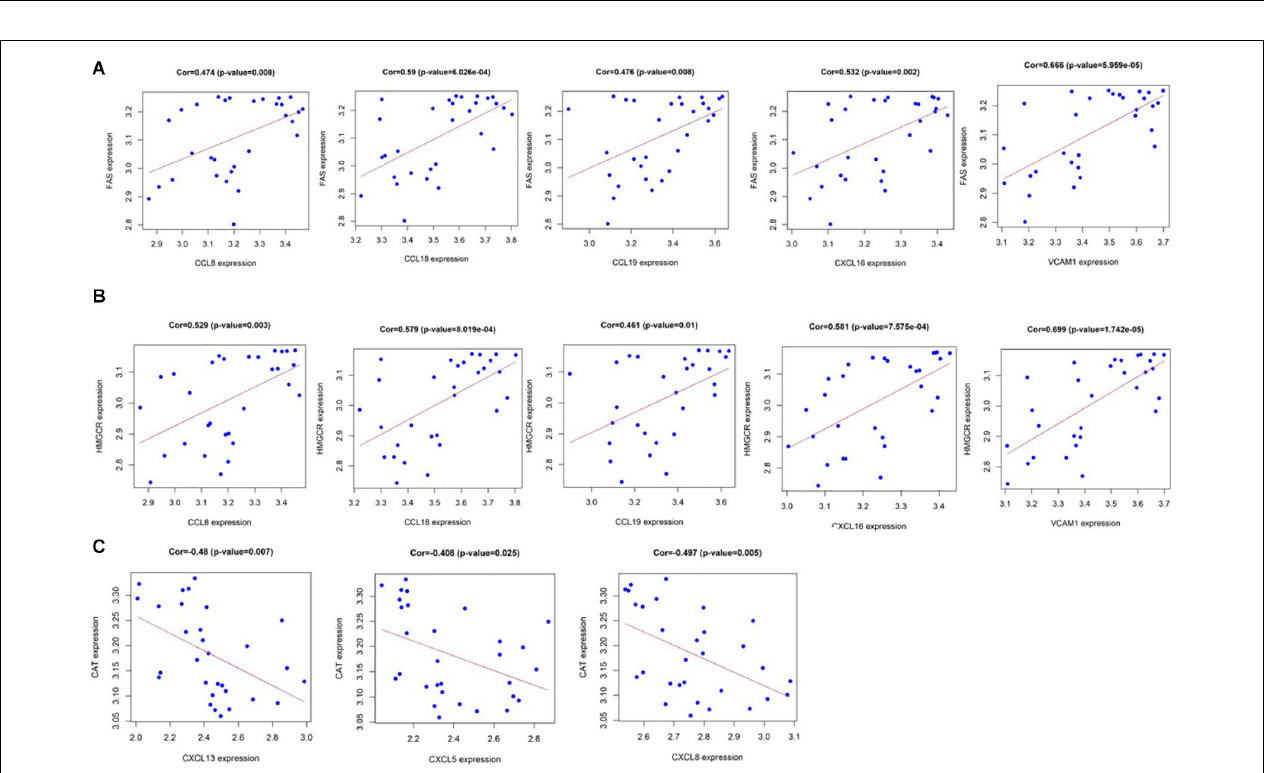
FIGURE 7 | (A) CCL8, CCL18, CCL19, CXCL16, and VCAM1 are positively correlated with fatty acid synthase (FAS); and (B) CCL8, CCL18, CCL19, CXCL16, and VCAM1 are positively correlated with hydroxymethylglutaryl coenzyme A reductase (HMGCR). (C) CXCL13, CXCL5, and CXCL8 have a strong negative correlation with lecithin cholesterol acyltransferase (CAT). P value <